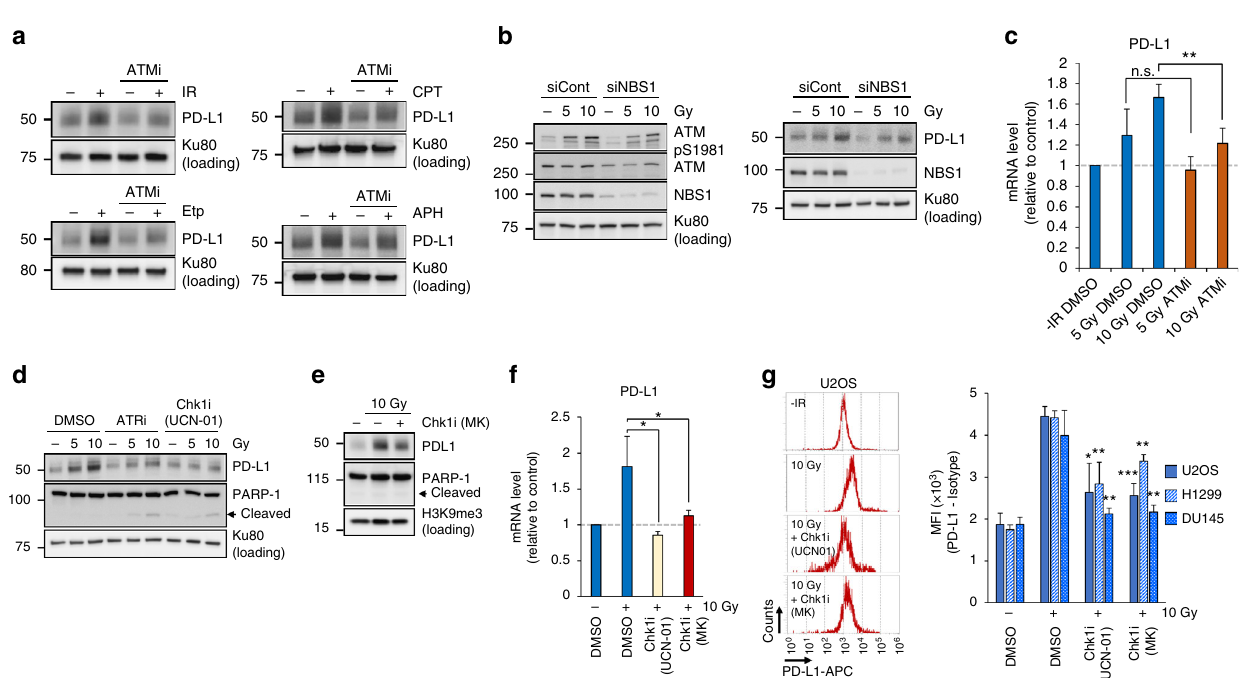
Fig. 2 PD-L1 upregulation requires ATM/ATR/Chk1 activity after DSBs. a ATM kinase activity is required for PD-L1 upregulation after IR. U2OS cells were treated with a speci fi c ATMi 15 min prior to IR, Etp, CPT or APH treatment. PD-L1 was examined 48 h after 10 Gy or the addition of 500 nM Etp, 50 nM CPT or 500 nM APH. b NBS1 depletion attenuates ATM auto-phosphorylation, which results in less PD-L1 upregulation. U2OS cells were exposed to NBS1 siRNA. ATM S1981 auto-phosphorylation was examined 30 min after 5 or 10 Gy (left panel). PD-L1 was examined 48 h after 5 or 10 Gy (right panel). c ATM kinase activity is required for the upregulation of PD-L1 mRNA expression. U2OS cells were harvested with or without ATMi after IR. PD-L1 mRNA was examined 48 h after 5 or 10 Gy. d ATR and Chk1 kinase activities are required for PD-L1 upregulation after IR. PD-L1 in U2OS cells was examined 48 h after 5 or 10 Gy with or without ATRi or Chk1i (UCN-01). e The Chk1 dependence was con fi rmed by another Chk1 inhibitor. PD-L1 in U2OS cells was examined 48 h after 10 Gy with or without Chk1i (MK8776). f Chk1 kinase activity is required for the upregulation of PD-L1 mRNA expression. U2OS cells were exposed to IR with or without Chk1i (UCN-01 or MK8776). PD-L1 mRNA was examined 48 h after 10 Gy. g Chk1 kinase activity is required for the upregulation of cell-surface PD-L1 after IR. PD-L1 in U2OS, H1299, DU145 cells was examined by fl ow cytometry at 48 h after 10 Gy with or without Chk1i (UCN-01 or MK8776). Statistical signi fi cance was examined compared with non-treated cells. Error bars represent the s.d. of three independent experiments ( c , f , g ). Statistical signi fi cance was determined using Student ’ s two-tailed t -test. * P < 0.05, ** P < 0.01, *** P <